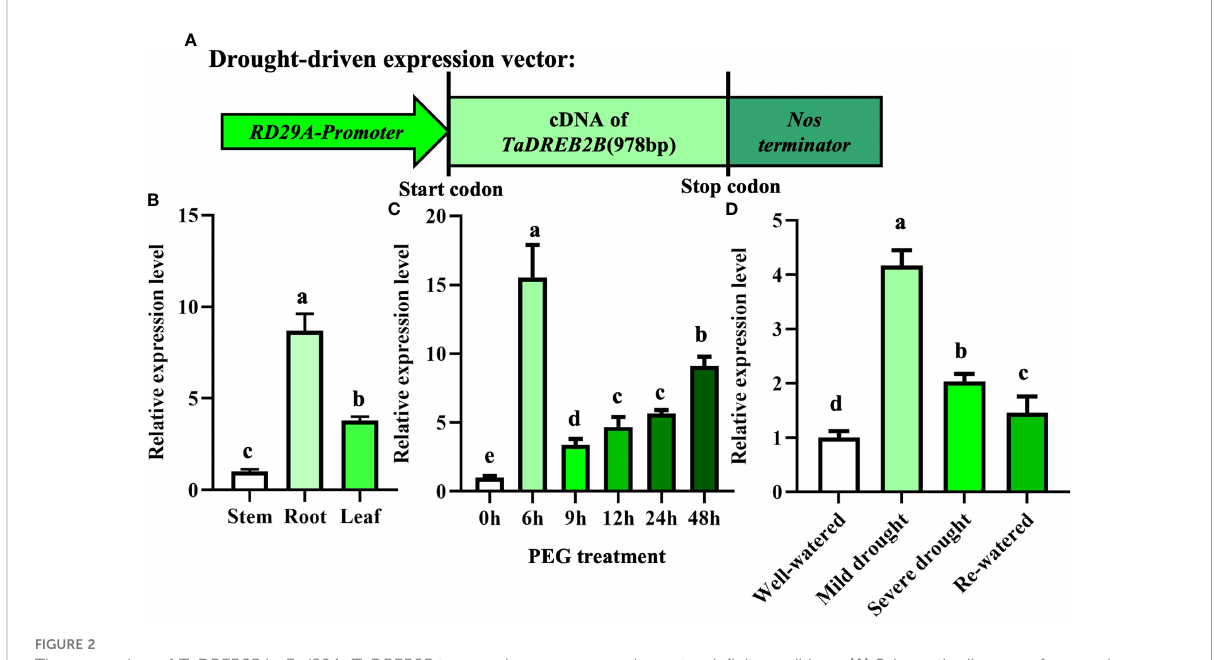
FIGURE 2 The expression of TaDREB2B in Prd29A: TaDREB2B transgenic sugarcane under water de fi cit conditions. (A) Schematic diagram of expression vector Prd29A: TaDREB2B used for sugarcane transformation. RD29A-Promoter represents the promoter of the RD29A gene in Arabidopsis . (B) The expression pattern of TaDREB2B in different tissues of transgenic sugarcane at the four-leaf stage after treatment with PEG. Samples of stem, root, and leaf were taken from plants at the four-leaf stage. The values are the means ± SD; n=3. (C) Expression of TaDREB2B at different time points following treatment of transgenic sugarcane seedlings at the four-leaf stage with PEG. The values are the means ± SD; n=3. (D) Relative expression of TaDREB2B following treatment of transgenic sugarcane seedlings subjected to different levels of water de fi cit. The values are the means ± SD; n=3. Different letters indicate signi fi cant differences as determined using ANOVA and LSD multiple comparisons ( P